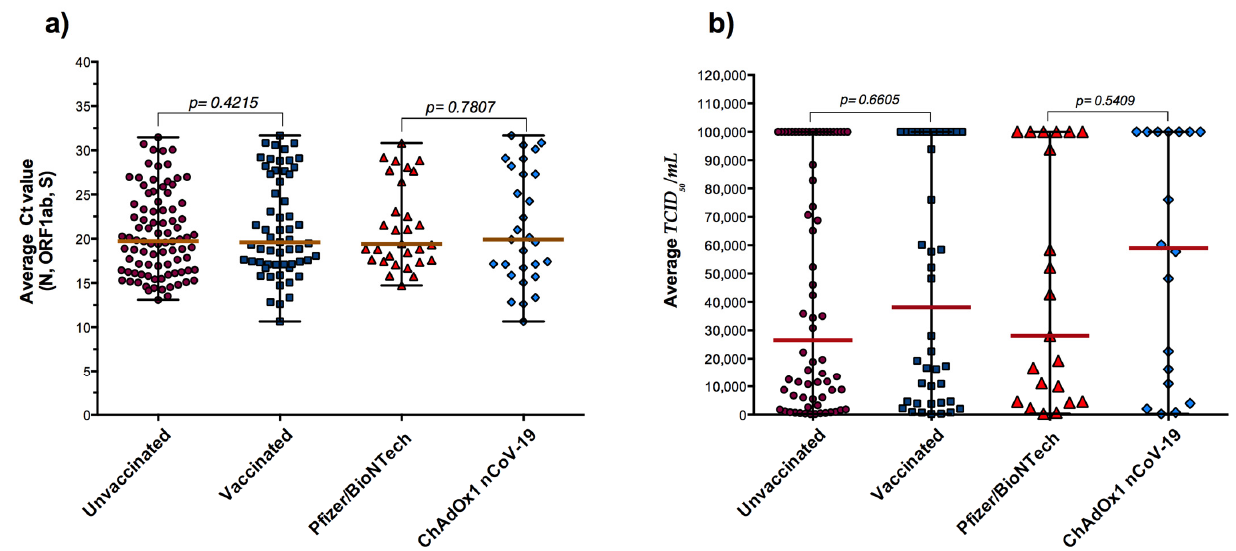
Figure 3. Cycle threshold (Ct) values for PCR-positive infections by vaccination status and type of vaccine. ( a ) Data are presented as RT-qPCR Ct values. ( b ) Data are presented as SARS-CoV-2 antigen levels obtained on the DiaSorin LIAISON SARS-CoV-2 Ag assay. Data are presented as median with range.